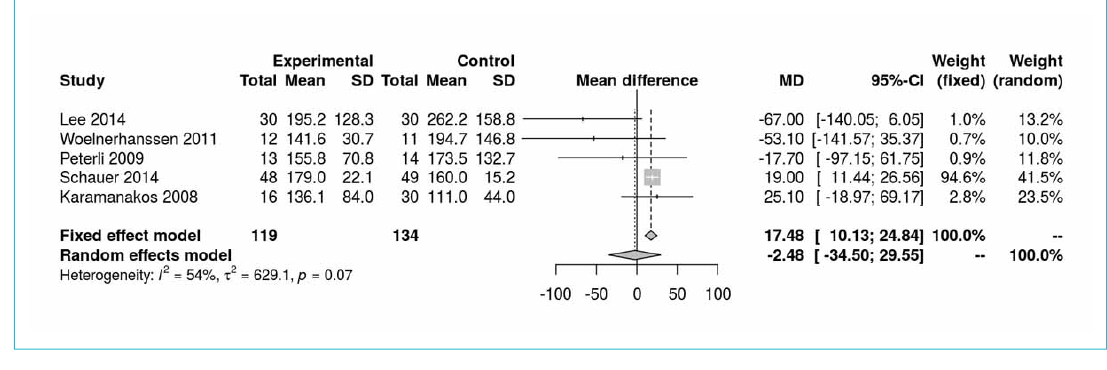
Figure S5c: Triglycerides at 12 months.